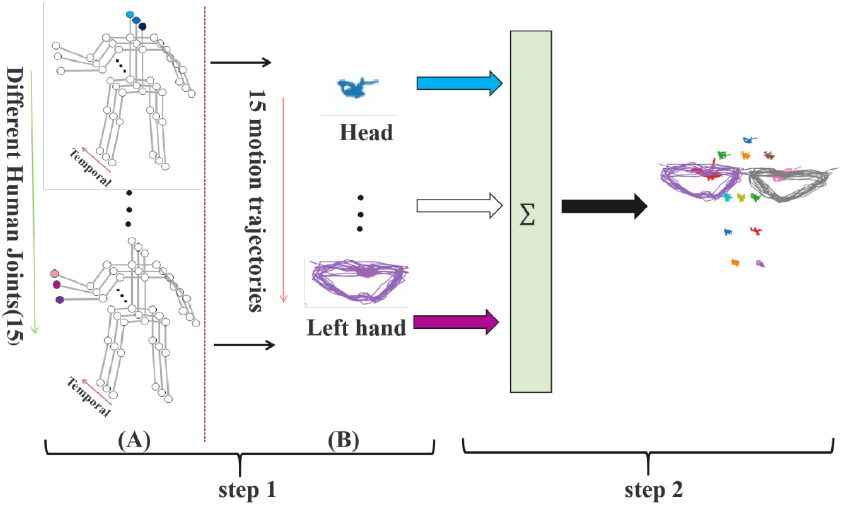
Figure 3. Flowchart of OFPI generation. ( A ) Visualization of skeletal data. ( B ) The trajectory of joint points changing over time.